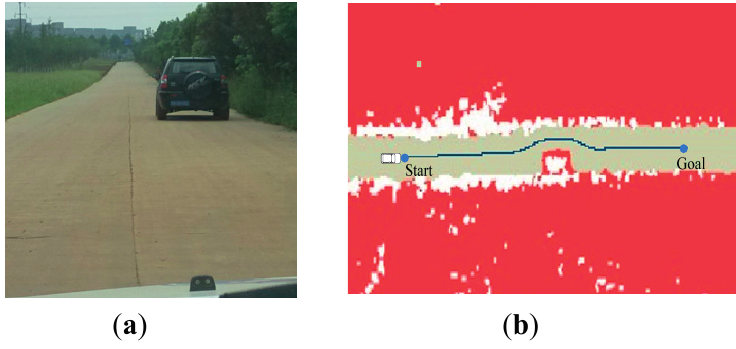
Figure 12. The experiment result in scenario 3. ( a ) shows navigating in the obstacle field; ( b ) shows the path generation result.